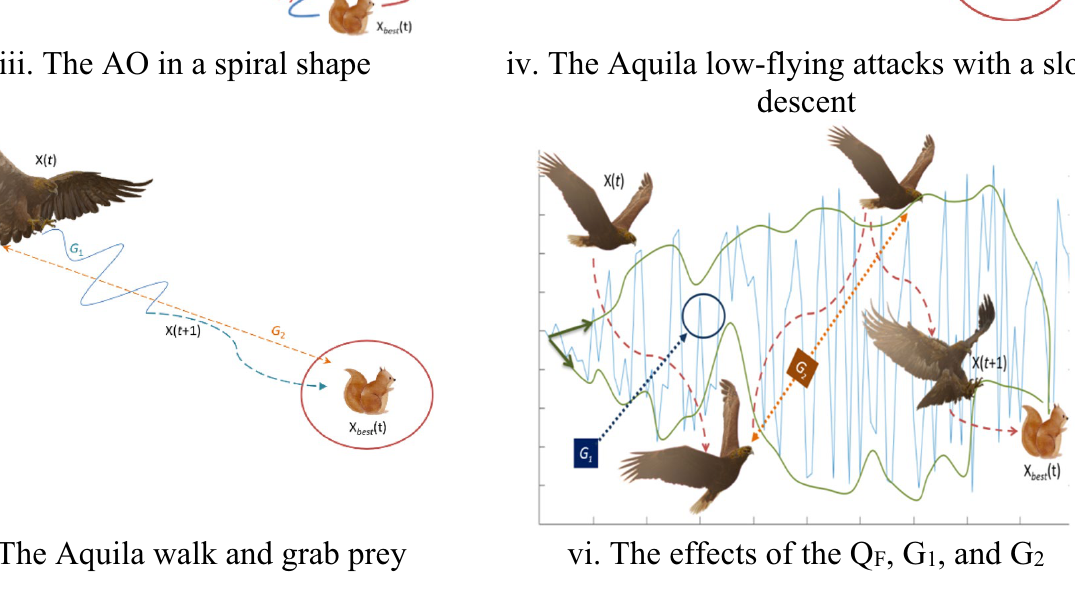
Figure 3. the schematic view of the OA